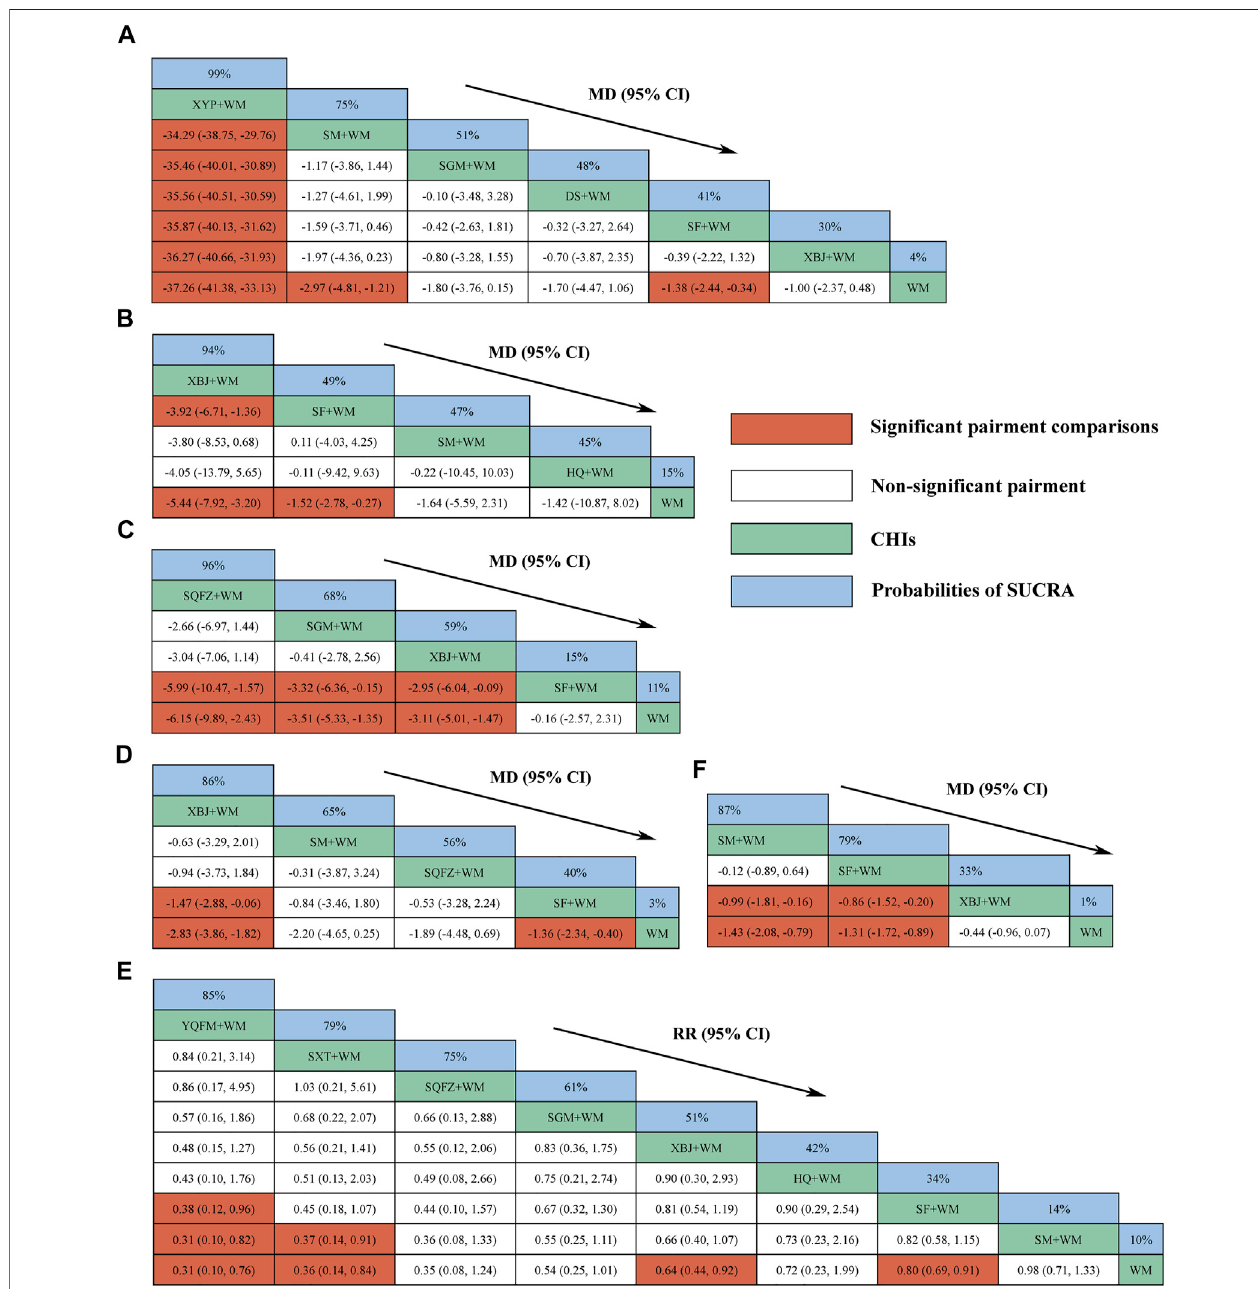
FIGURE 4 | Relative effect sizes of ef fi cacy at interventions in each outcome (A) Procalcitonin level at day 7 after interventions (B) ICU length of stay (C) Hospital length of stay (D) SOFA score at day 7 after interventions (E) 28-days-motality (F) Serum lactate level at day 7 after interventions; CHIs, Chinese herbal injections; WM, Western Medicine; SF, Shenfu injection; SM, Shenmai injection; SGM, Shengmai injection; XBJ, Xuebijing injection; YQFM, Yiqifumai injection; DS, Danshen injection; HQ, Huangqi injection; SXT, Shuxuetong injection; SQFZ, Shenqifuzheng injection; XYP, Xiyanping injection; SUCRA, surface under the cumulative ranking area curves. Highest probability of being the most ef fi cient CHIs (With high SUCRA values) and Lowest probability of being the most ef fi cient CHIs (With low SUCRA values).